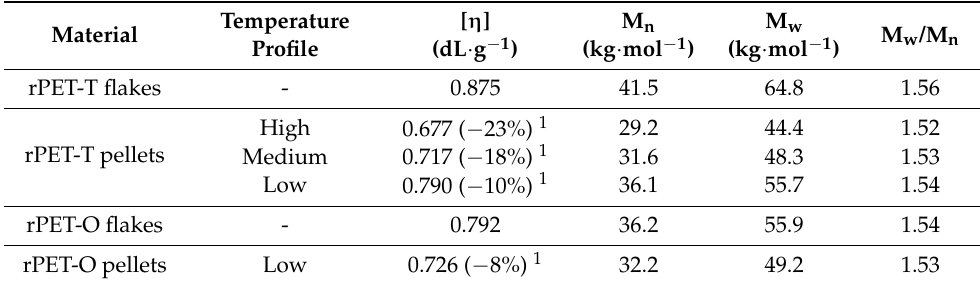
Table 2. Intrinsic viscosity at 25 ◦ C and MW parameters for rPET-T and rPET-O unprocessed flakes and homogenized pellets, respectively.